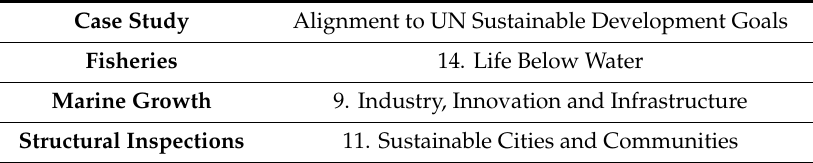
Table 1. Alignment of Case Studies to UN Sustainable Development Goals.